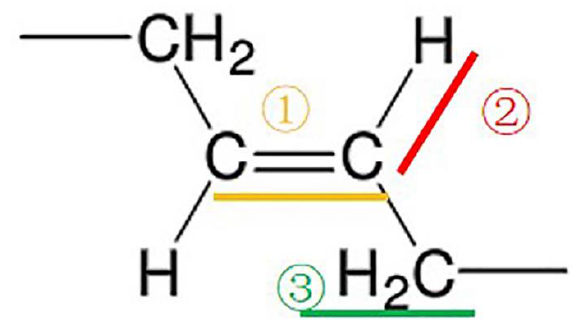
Figure 8. Structure of